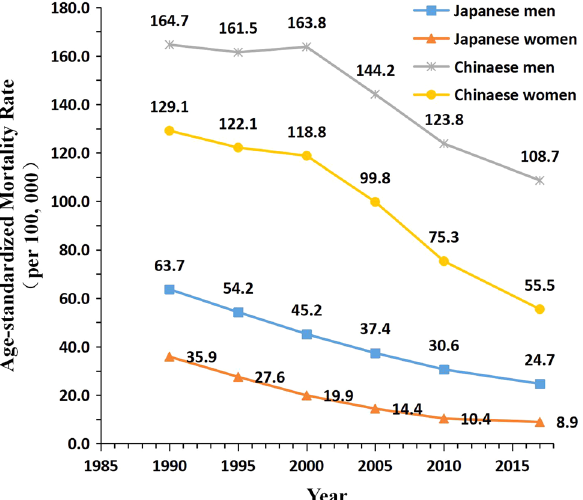
Figure 1. Trends of the age-standardized mortality rates (ASMR) per 100 000 population for high SBP- attributable stroke mortality by sex in China and Japan, 1990 to 2017. Standardized to the GBD 2013 (Global Burden of Disease Study 2013) global age-standard population. Japanese men 1990: Population: 38 067 229; Stroke: 38 690, 1995: Population: 40 061 997; Stroke: 43 172, 2000: Population: 42 325 105; Stroke: 53 896, 2005: Population: 43 537 328; Stroke: 56 710, 2010: Population: 43 9242 91; Stroke: 51 523, 2017: Population: 43 375 707; Stroke: 49 687. Japanese women 1990: Population: 40 384 673; Stroke: 38 284, 1995: Population: 42 106 114; Stroke: 36 083, 2000: Population: 44 166 128; Stroke: 33 924, 2005: Population: 45 113 407; Stroke: 27 271, 2010: Population: 45 222 792; Stroke: 21 438, 2017: Population: 44 420 972; Stroke: 18 971. Chinese men 1990: Population: 290 646 432; Stroke: 2 169 970, 1995: Population: 337 919 965; Stroke: 2 769 952, 2000: Population: 380 394 008; Stroke: 3 551 441, 2005: Population: 409 095 096; Stroke: 4 620 059, 2010: Population: 436 732 774; Stroke: 5 592 961, 2017: Population: 483 291 490; Stroke: 7 389 792. Chinese women 1990: Population: 275 594 048; Stroke: 1 336 893, 1995: Population: 322 776 513; Stroke: 1 643 057, 2000: Population: 365 152 409; Stroke: 2 082 019, 2005: Population: 393 674 755; Stroke: 2 545 186, 2010: Population: 421 787 480; Stroke: 2 723 681, 2017: Population: 466 391 682; Stroke: 3 082